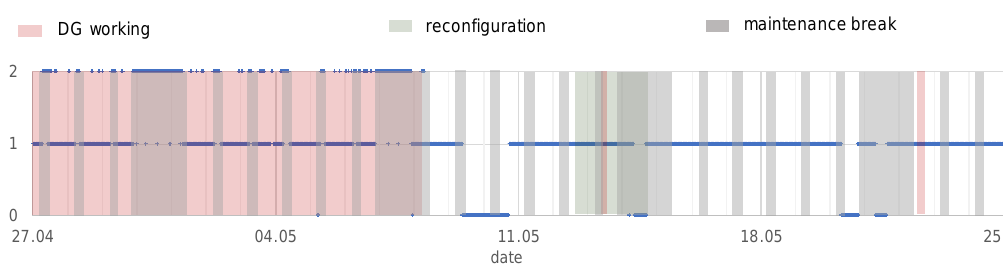
Figure 5. Cluster analysis results for the final number of clusters equal to 2.